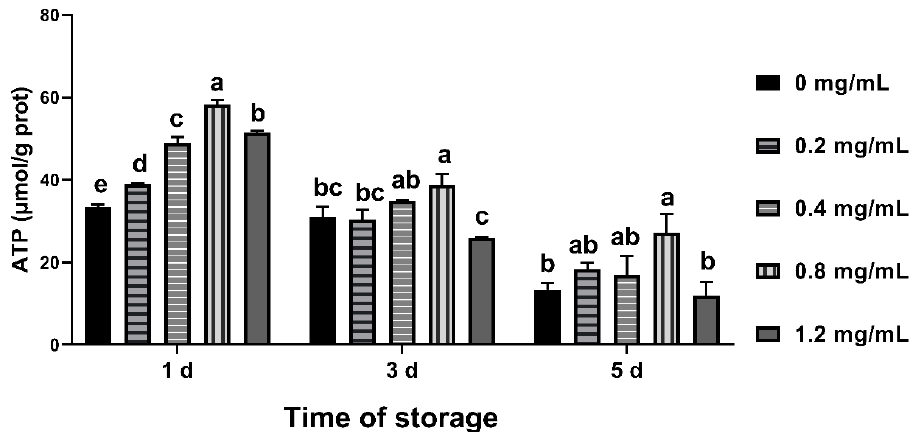
Figure 6. Effects of CGA with different concentrations on ATP content of chilled ram sperm. Note: Different letters above the column indicate significant difference, the same or containing the same letter indicate insignificant difference.